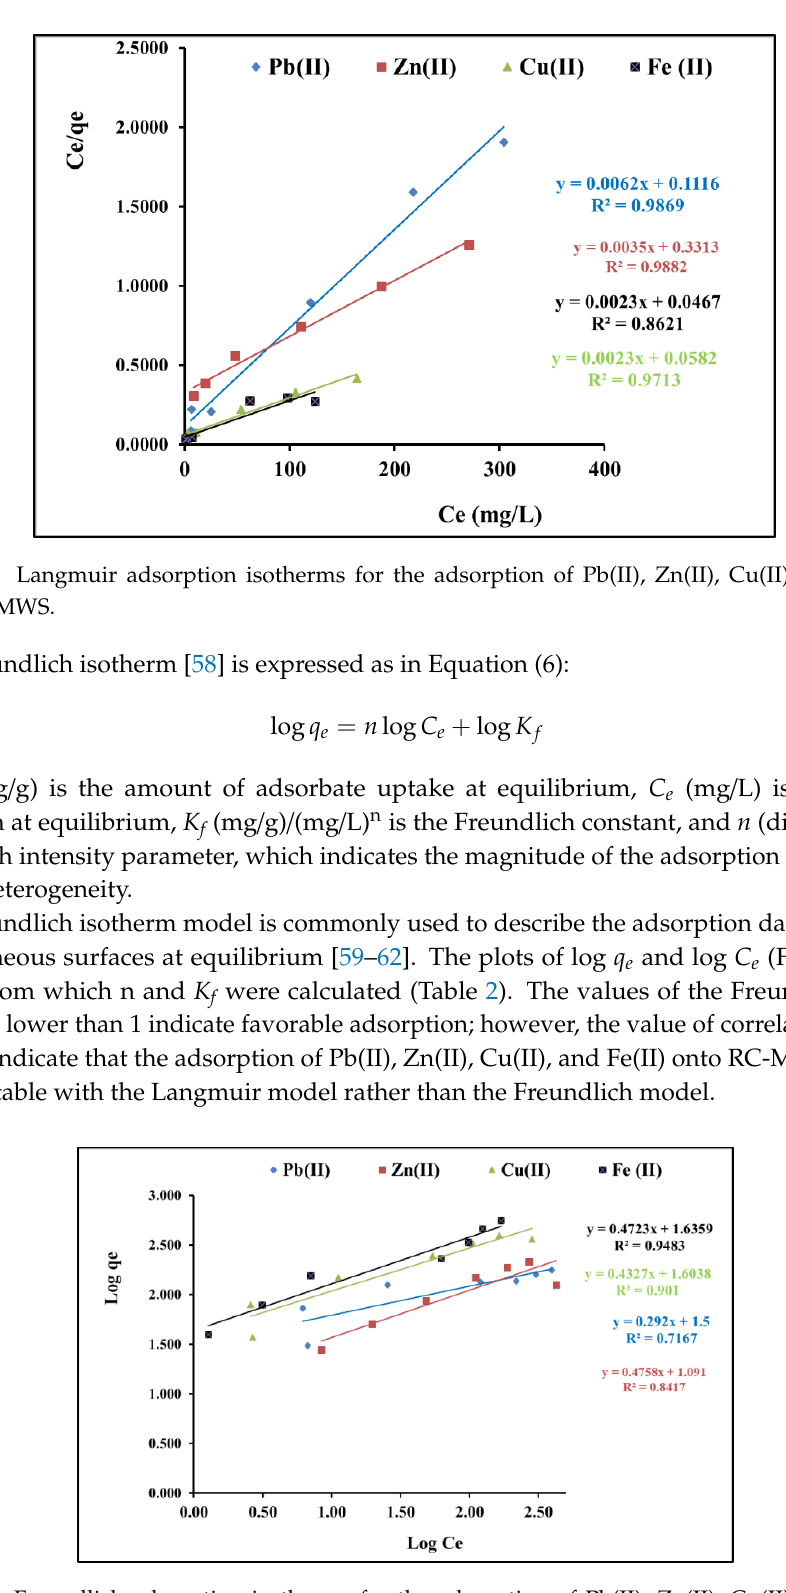
Figure 7. Freundlich adsorption isotherms for the adsorption of Pb(II), Zn(II), Cu(II), and Fe(II) onto RC-MWS. Table 2. Langmuir and Freundlich constants for the adsorption of Pb(II), Zn(II), Cu(II), and Fe(II) onto RC-MWS.